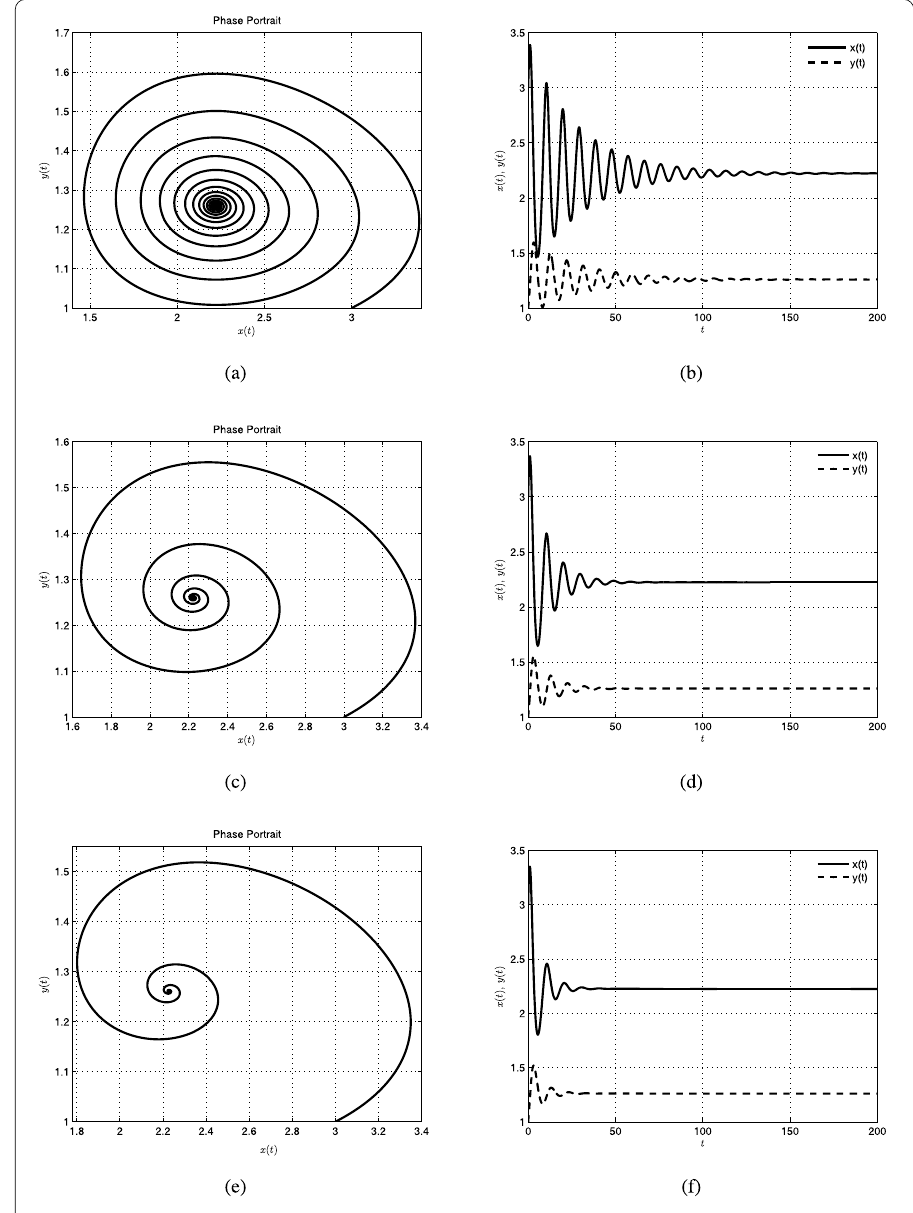
Figure 1 Numerical simulation for the prey–predator model via Atangana–Baleanu–Caputo fractional derivative with constant order (2.1) via the numerical scheme given by Eq. (3.22). In ( a )–( b ) phase portrait and time series x ( τ ) and y ( τ ) for (cid:2) = 1 and ς = 1. In ( c )–( d ) phase portrait and time series x ( τ ) and y ( τ ) for (cid:2) = 0.95 ς = 0.9. In ( e )–( f ) phase portrait and time series x ( τ ) and y ( τ ) for (cid:2) = 0.9 and ς =